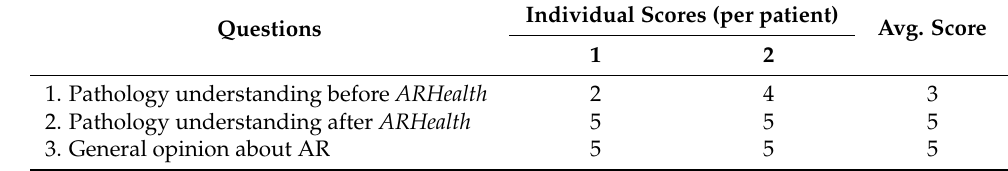
Table 5. Patients’ survey